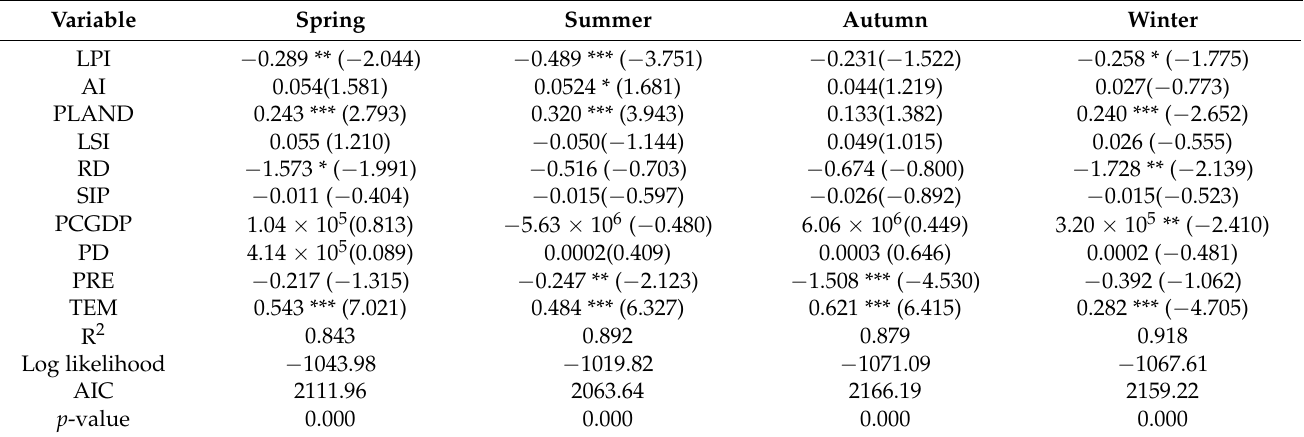
Table 4. Spatial lag model results for different seasons in China during